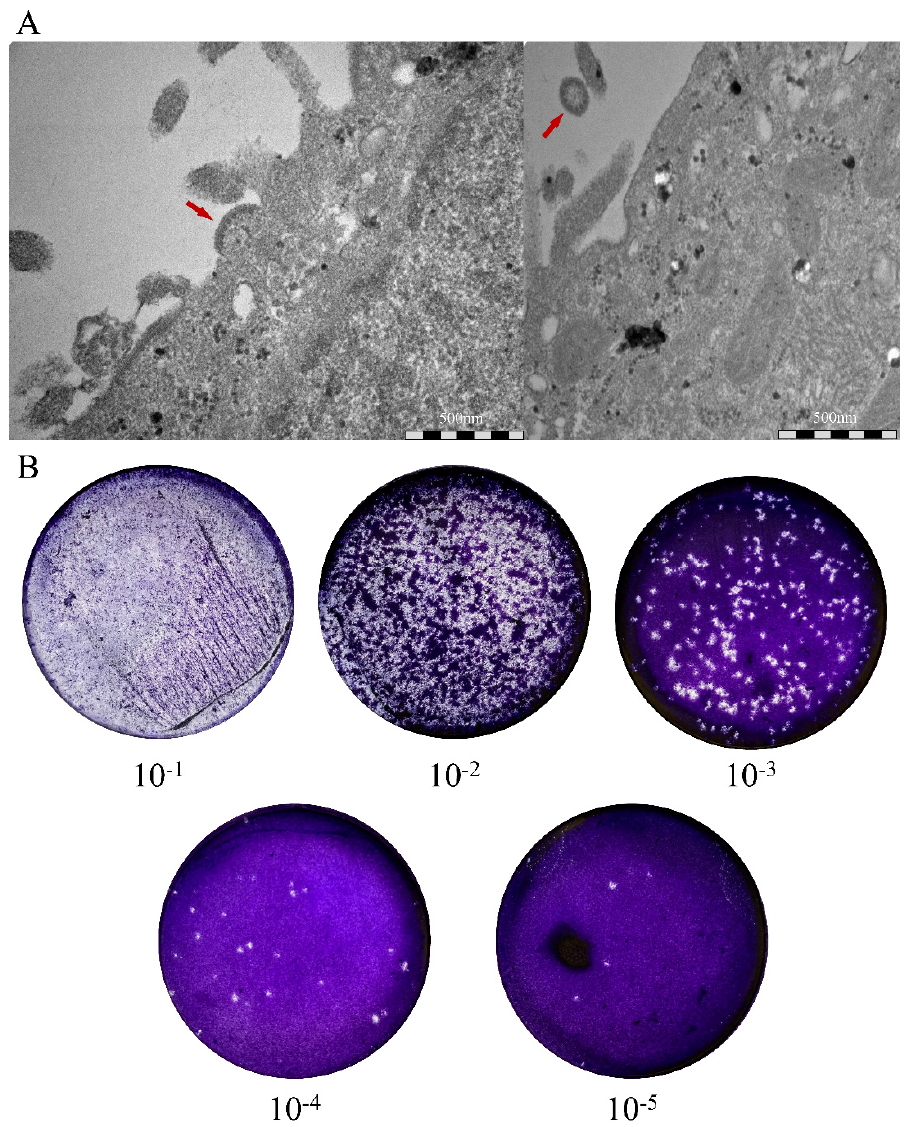
Figure 2. Transmission electron micrograph and quantitation of Gamak virus (GAKV). ( A ) The appearance of GAKV isolate was obtained by using the transmission electron microscopy. Red arrows indicate virus particles. ( B ) The plaque assay shows infectious GAKV inoculated onto Vero E6 cells. Each plate well represents the quantitation of infectious particles at serial dilutions from 1:10 to 1:10 5 of the virus stock.